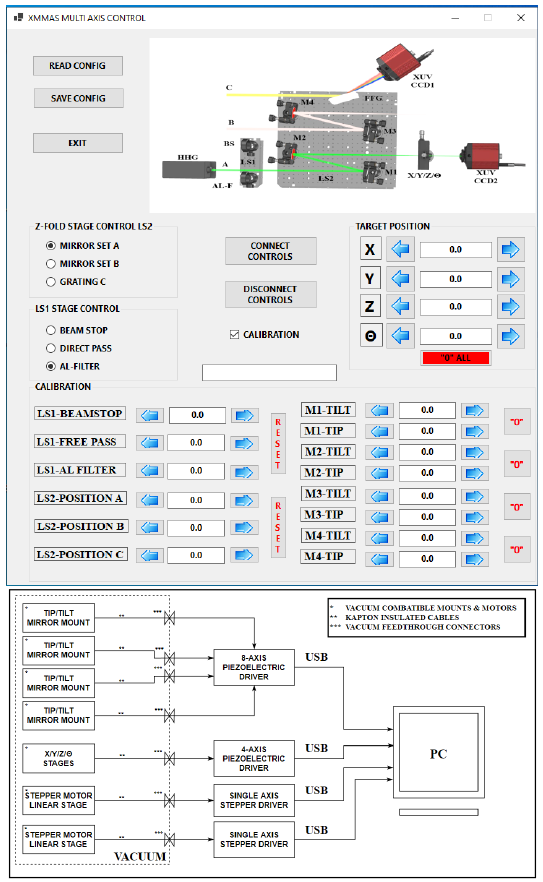
Figure A1. ( Top ) The software interface for controlling all the optomechanical components installed inside the vacuum Stages C and D of the setup. ( Bottom ) Schematic of the multi-axis control electronic block